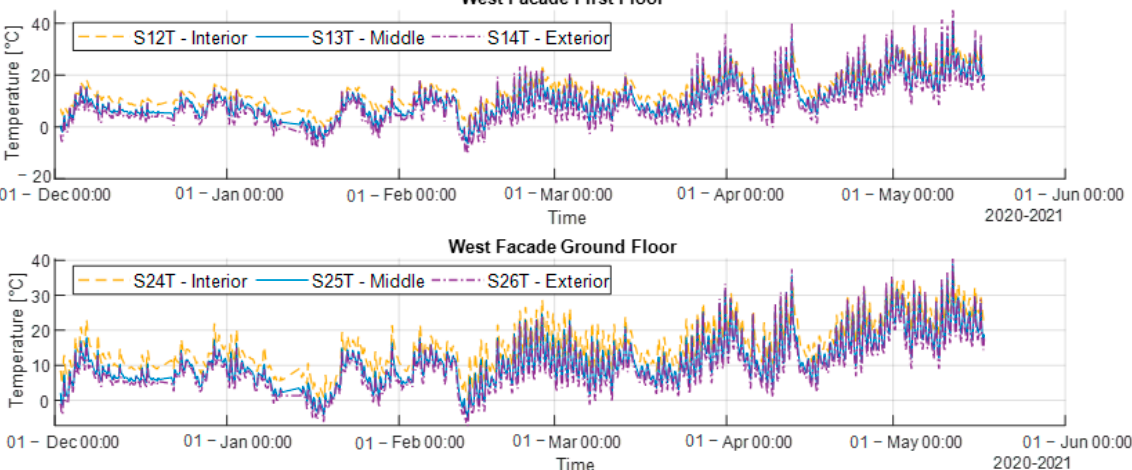
Figure 15. Temperature data provided by the sensors for the western façade first floor (above) and ground floor (below).